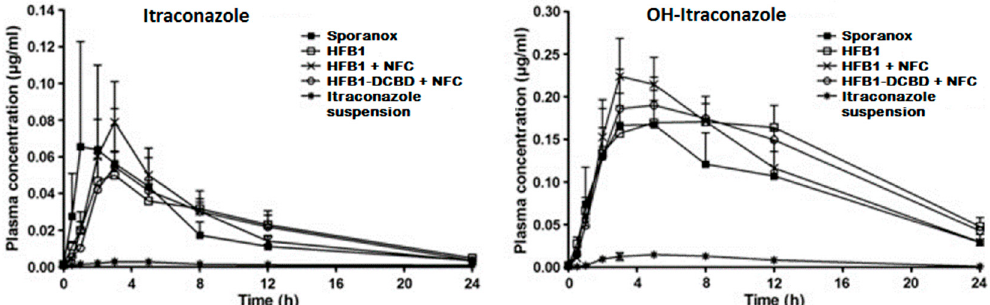
Figure 1. Plasma concentration–time profiles of itraconazole ( left ) and OH-itraconazole ( right ) in rats after oral administration of Sporanox ® , three different hydrophobin coated nanocrystal formulations and itraconazole microsuspension in rats. AUC values for nanocrystal formulations were 1.2–1.3-fold higher than with Sporanox ® (reprinted from [6] with permission. Copyright Elsevier 2011).